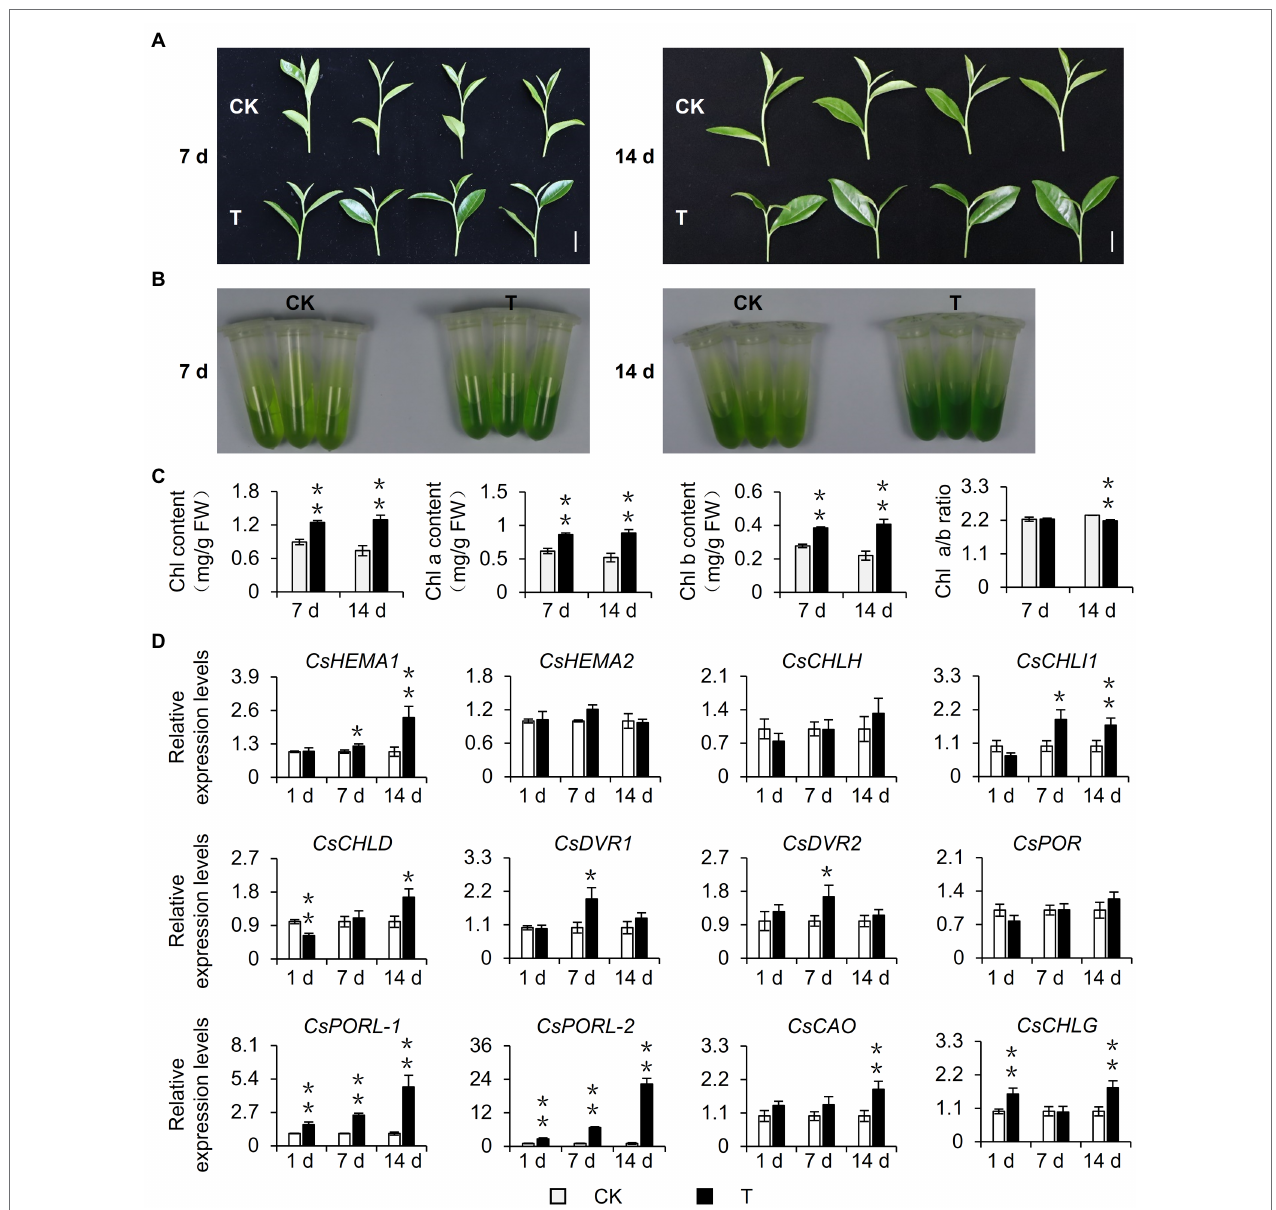
FIGURE 1 | Effect of shading treatment on the chlorophyll content of tea leaves and the expression of related genes. (A) The phenotype of new shoots after 7 day and 14 day shading treatment. Bar = 2 cm. (B) The comparison of leaf pigments after 7 day and 14 day shading treatment. (C) The change of chlorophyll content after shading treatment. Chl: total chlorophyll; Chl a: chlorophyll a; Chl b: chlorophyll b; and FW: fresh weight. (D) The changes in the gene expression of chlorophyll synthesis pathway after shading treatment. CK: no shading treatment group (about 1,300 μ mol m − 2 s − 1 ); T: 90% shading treatment group (about 130 μ mol m − 2 s − 1 ). CsEF1- α was used as an internal reference to normalized the changes. Data are expressed as mean ± SD ( n = 3). * p ≤ 0.05; ** p ≤ 0.01; and difference from CK treatment at the same time